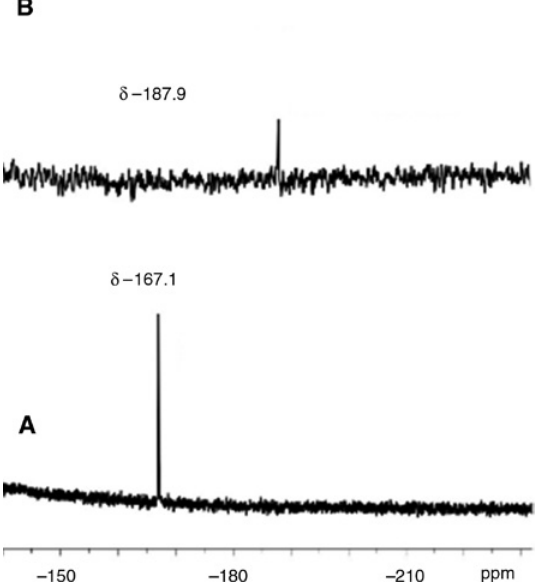
Figure 6: 29 Si spectra of complexes (A) 14 and (B) 15 in a DMSO-D